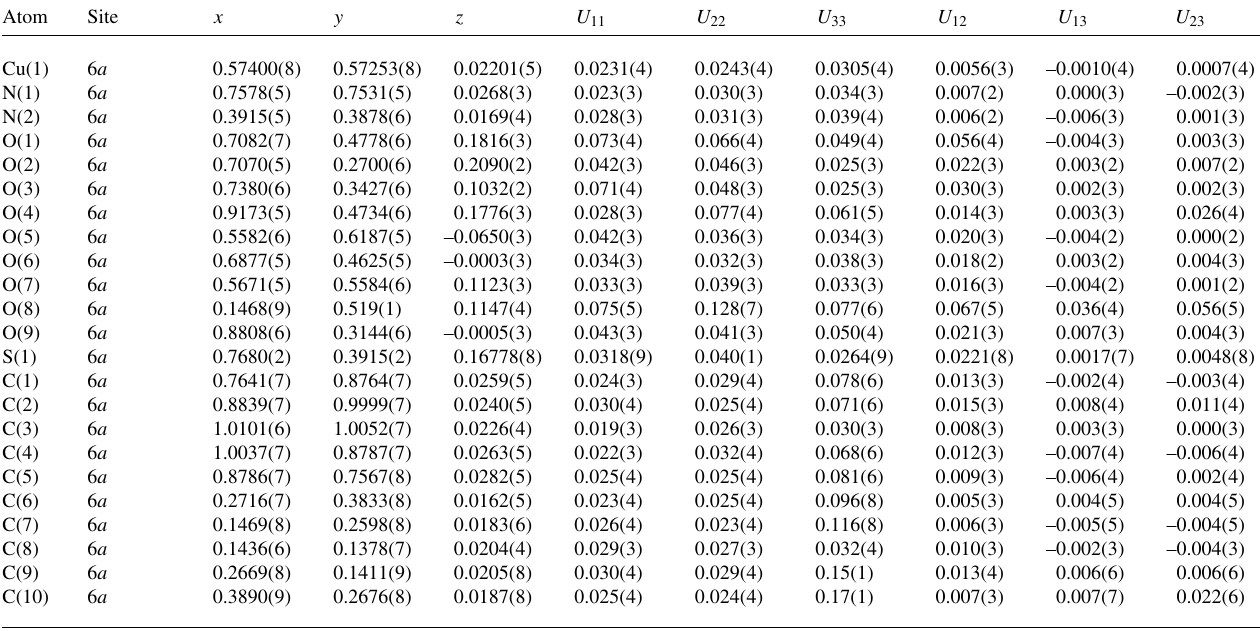
Table 3. Atomic coordinates and displacement parameters (in Å 2 )